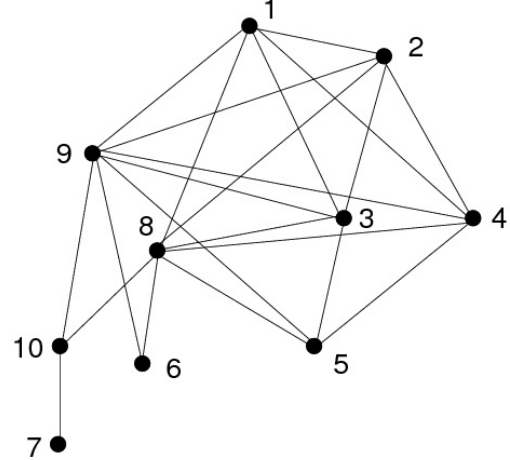
Figure 8 . A LexBFS execution on a non-chordal graph. Moplex containing α (1) : X = { 1 , 2 } . Components of G ( V − X 1 C = { 5 } . N ( C ) = N ( C ) = { 9 , 8 } , N ( C 3 1 2